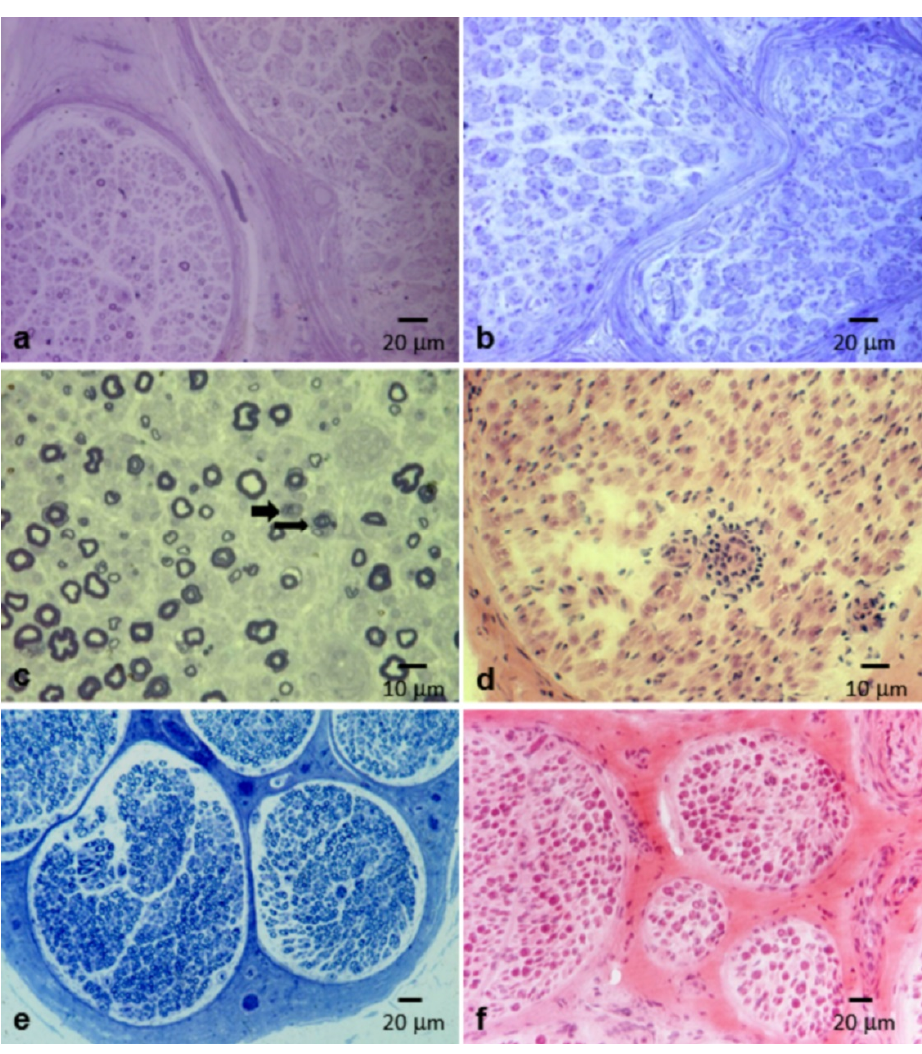
Figure 7. Different pathological alterations in CIDP ( a – c ) and normal age-matched control ( e , f ). ( a–c ) Semithin section from CIDP patients stained with toluidine blue. ( a ) Sural nerve biopsy from a 64-year-old woman with “typical” CIDP. Two contiguous fascicles with completely different aspects: in one, only a loss of myelin fibers is observed; while in the other, fibers are extremely reduced in number and are all surrounded by onion bulbs. ( b ) Sural nerve biopsy from a 47-year-old woman with “typical” CIDP: marked reduction of myelinated fibers, all surrounded by onion bulbs, is observed. ( c ) Sural nerve biopsy from a 65-year-old man with “atypical” CIDP (MADSAM, shown in Figure 5a,b): slight reduction of myelin fibers and active axonal degenerations (arrows) are observed. ( d ) Hematoxylin and eosin (H&E) staining from a CIDP patient. Sural nerve biopsy from a 53-year-old man with “typical” CIDP: an endoneural inflammatory infiltrate is present. ( e ) Semithin section from a normal subject stained with toluidine blue. ( f ) H&E staining from a normal subject. Subperineural edema was detected in four patients (9.3%), and endoneural edema in another